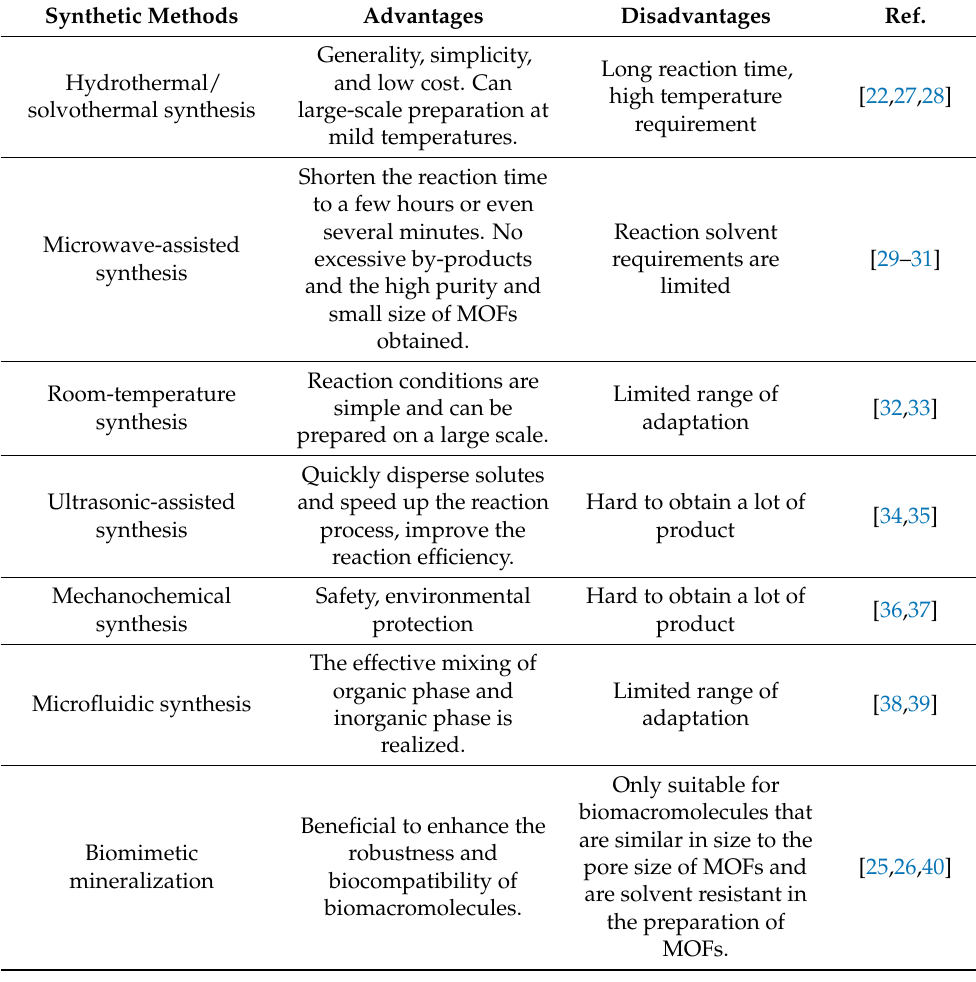
Table 1. Comparison of advantages and disadvantages of MOF synthesis